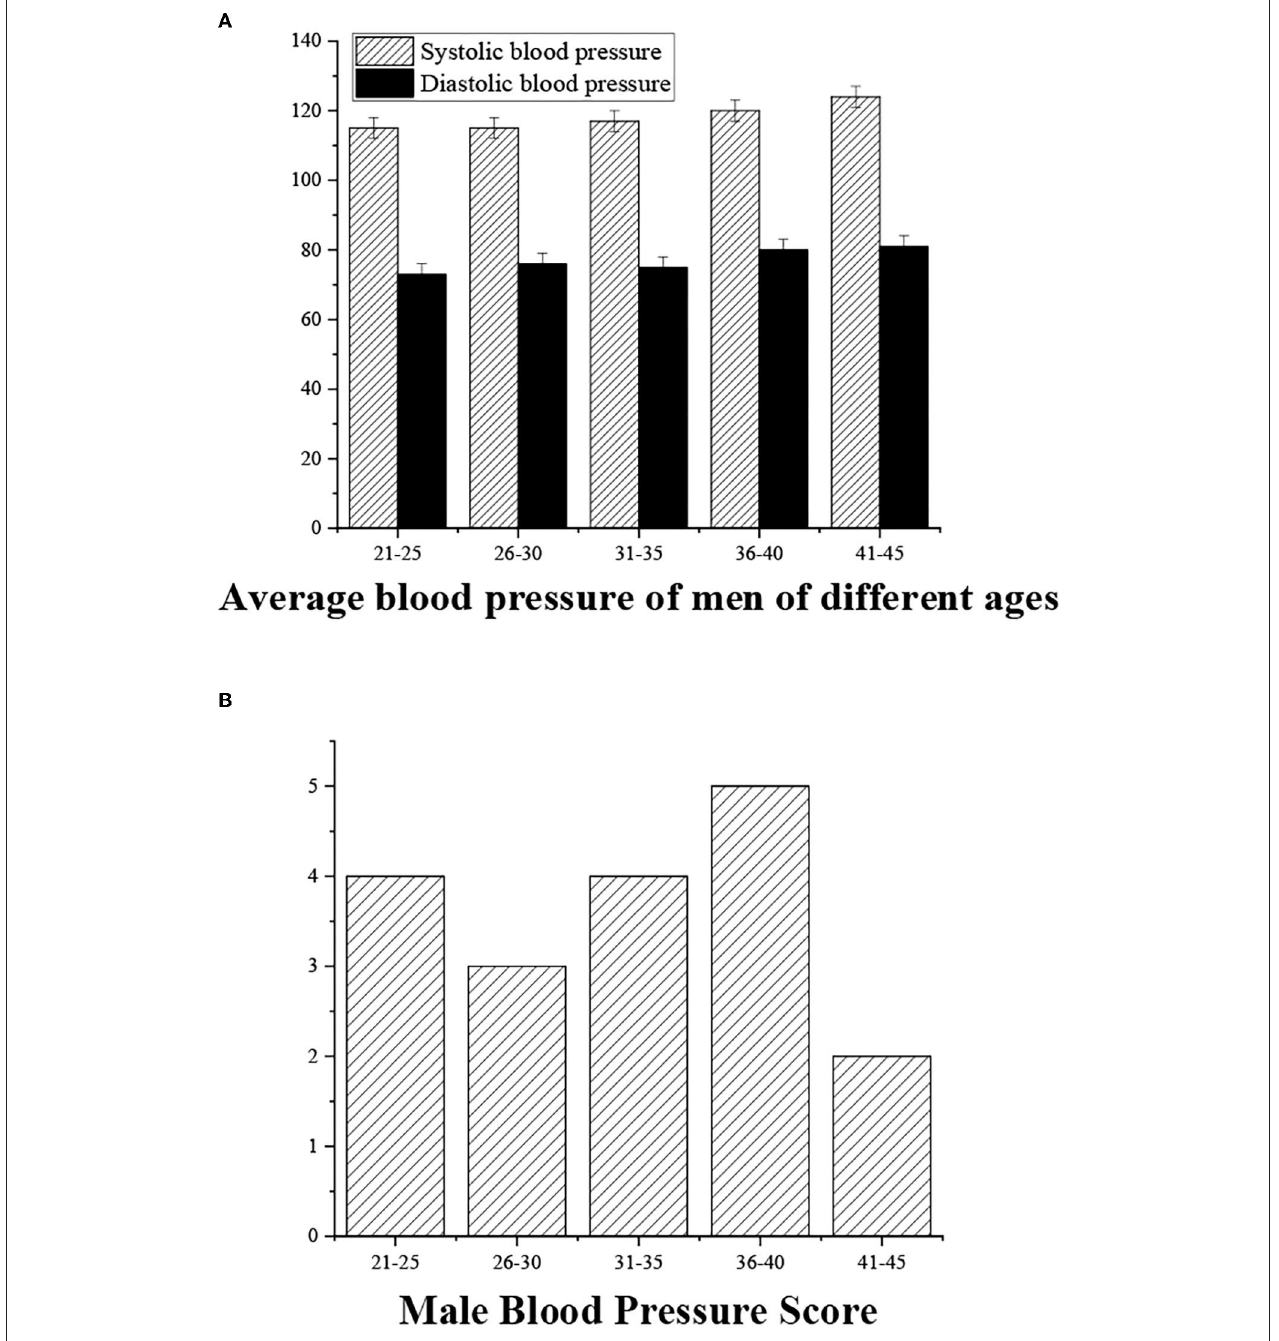
FIGURE 4 | (A) Statistical average blood pressure (SBP/DBP) for men of different ages. (B) Blood pressure measurement